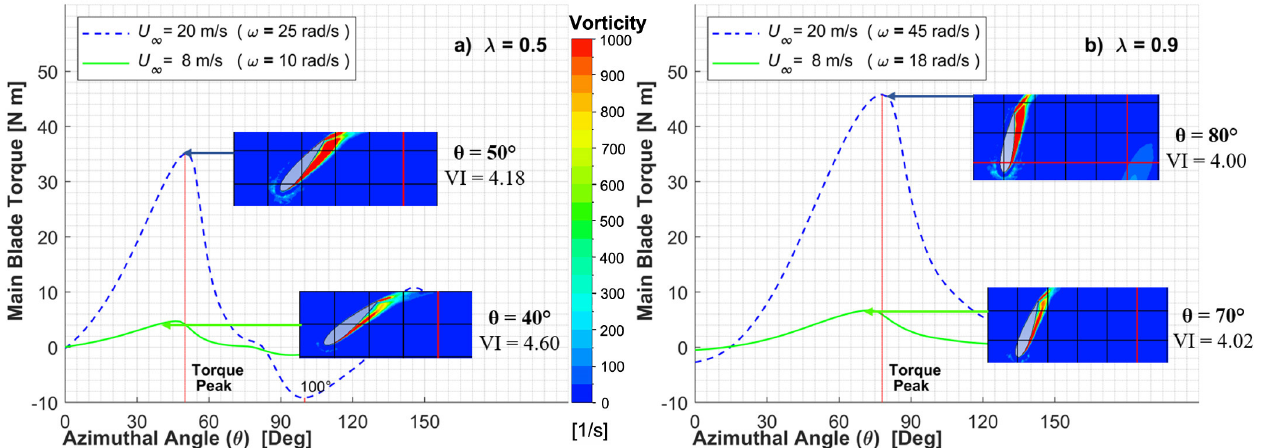
Figure 19. Torque and VI for Blade 1 with Azimuthal Position for 𝑈 (cid:2998) = 8 m/s and 𝑈 (cid:2998) = 20 m/s at: (a) 𝜆 = 0.5 and (b) 𝜆 = 0.9, Using the 2D Model of the Present Study. ( a ) λ = 0.5 and ( b ) λ = 0.9, Using the 2D Model of the Present